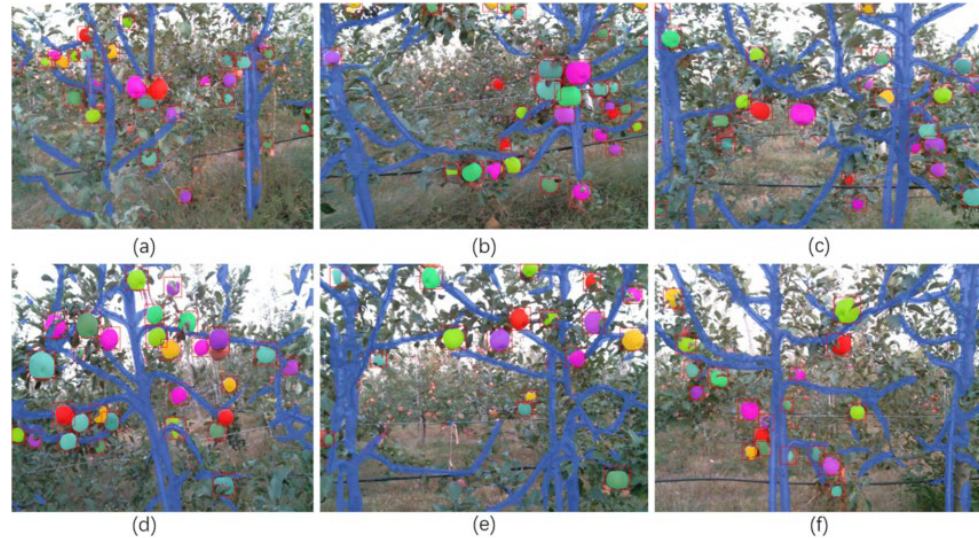
Figure 3. Detection and segmentation of fruit and branch [106].